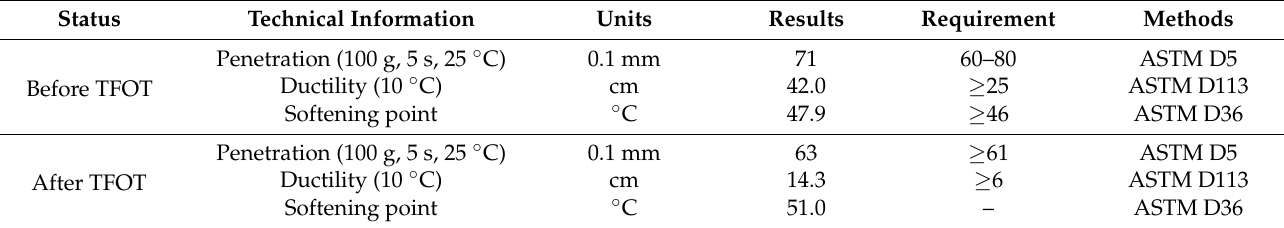
Table 1. Technical information of the 70# asphalt binder [27].